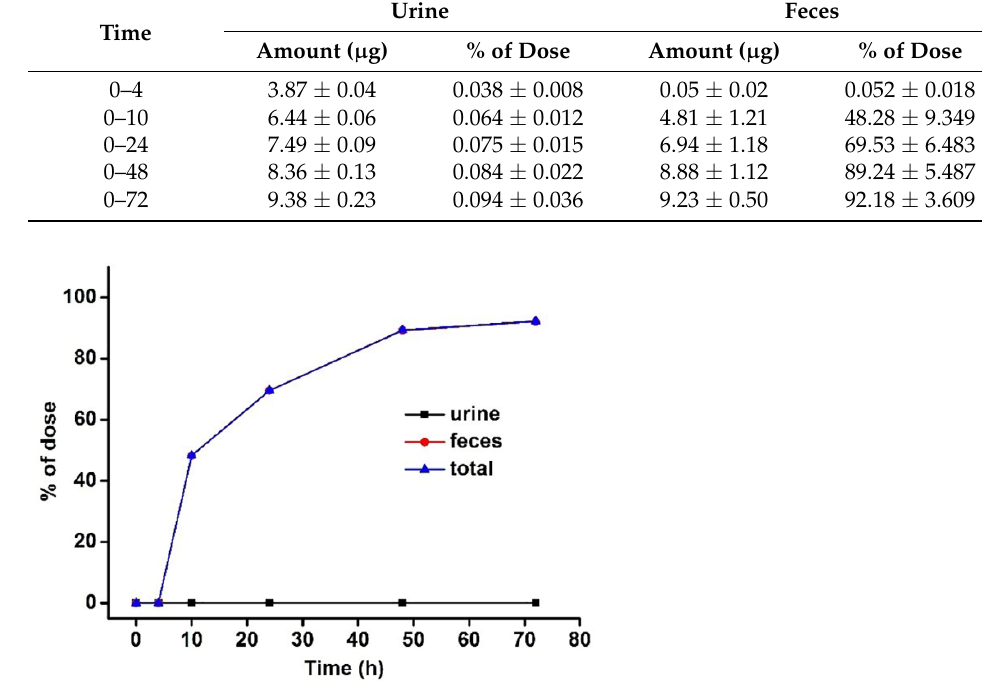
Figure 3. The percentage of cumulative amount of LBP-FITC excreted in rat urine and feces in dose after a single i.g. dose of 50 mg/kg LBP-FITC.